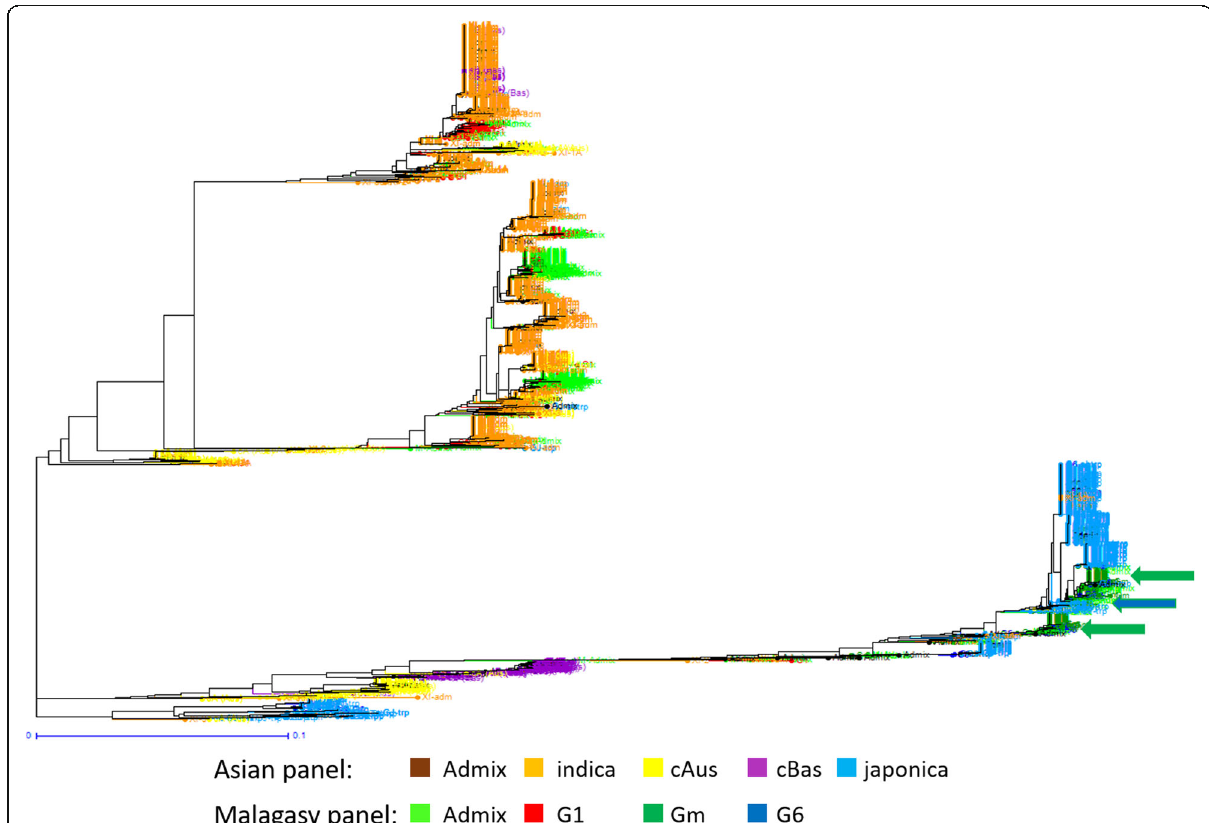
Fig. 5 Unweighted neighbour-joining tree of simple matching distances, constructed with the genotypic data at 13.0 – 17.7 Mb segment of chromosome 6 (240 SNP). Accessions of the Asian panel are coloured according to their membership to major populations defined by Wang et al. (2018). Accessions of the Malagasy panel are coloured according to their membership of sNMF groups at K = 3 and ancestry coefficient threshold of 0.8. Positions of G6 and Gm accessions on the trees are highlighted with coloured arrows corresponding to their group